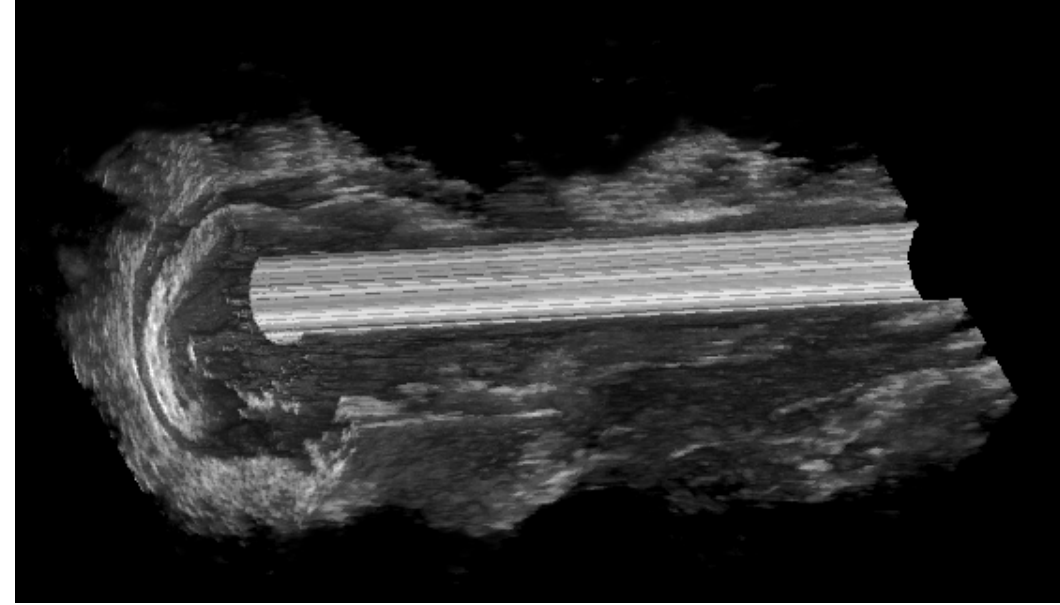
FIGURE 5. Pancreatic cancer of the body of the pancreas with portal vein involvement; 3-D reconstruction using a linear probe